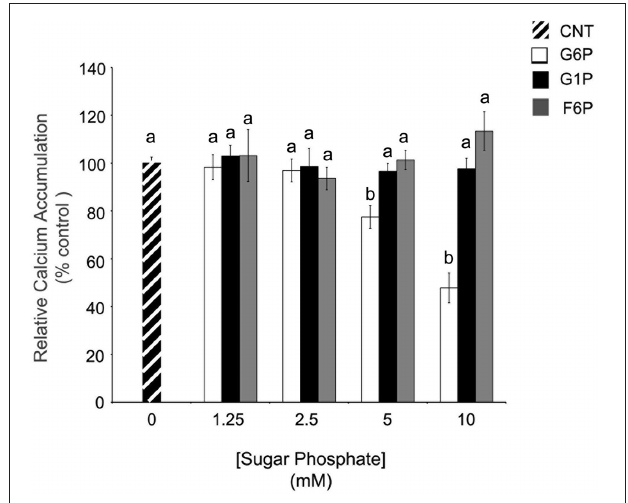
FIGURE 1 | In comparison to other hexose phosphates, glucose-6-phosphate reduces the accumulation of 45 Ca 2 + in brain ER microsomes. Addition of glucose-6-phosphate (10mM), but not glucose-1-phosphate (10mM) or fructose-6-phosphate (10mM), significantly reduced ( p < 0 . 05) calcium accumulation. Data are means ± SEM for n = 5. Each microsomal preparation contained a minimum of eight whole brains pooled together. ab Means with differing superscripts are significantly different, p < 0 . 05, while means that share superscripts are not significantly